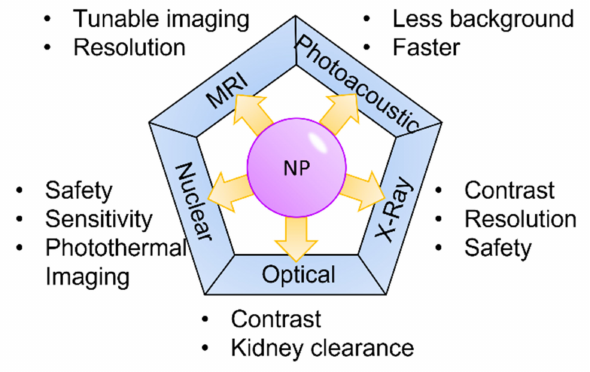
Figure 4. Nanoparticles and medical